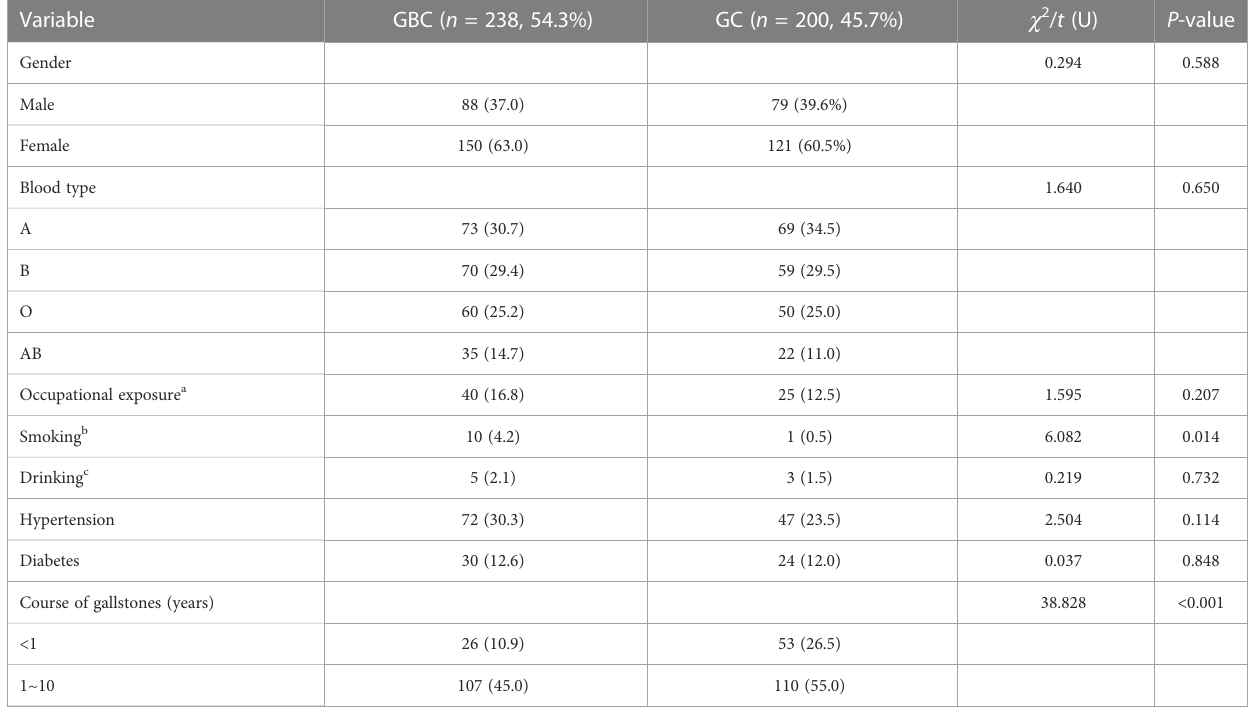
TABLE 1 Comparison of general data between GBC and GS in the internal test samples.